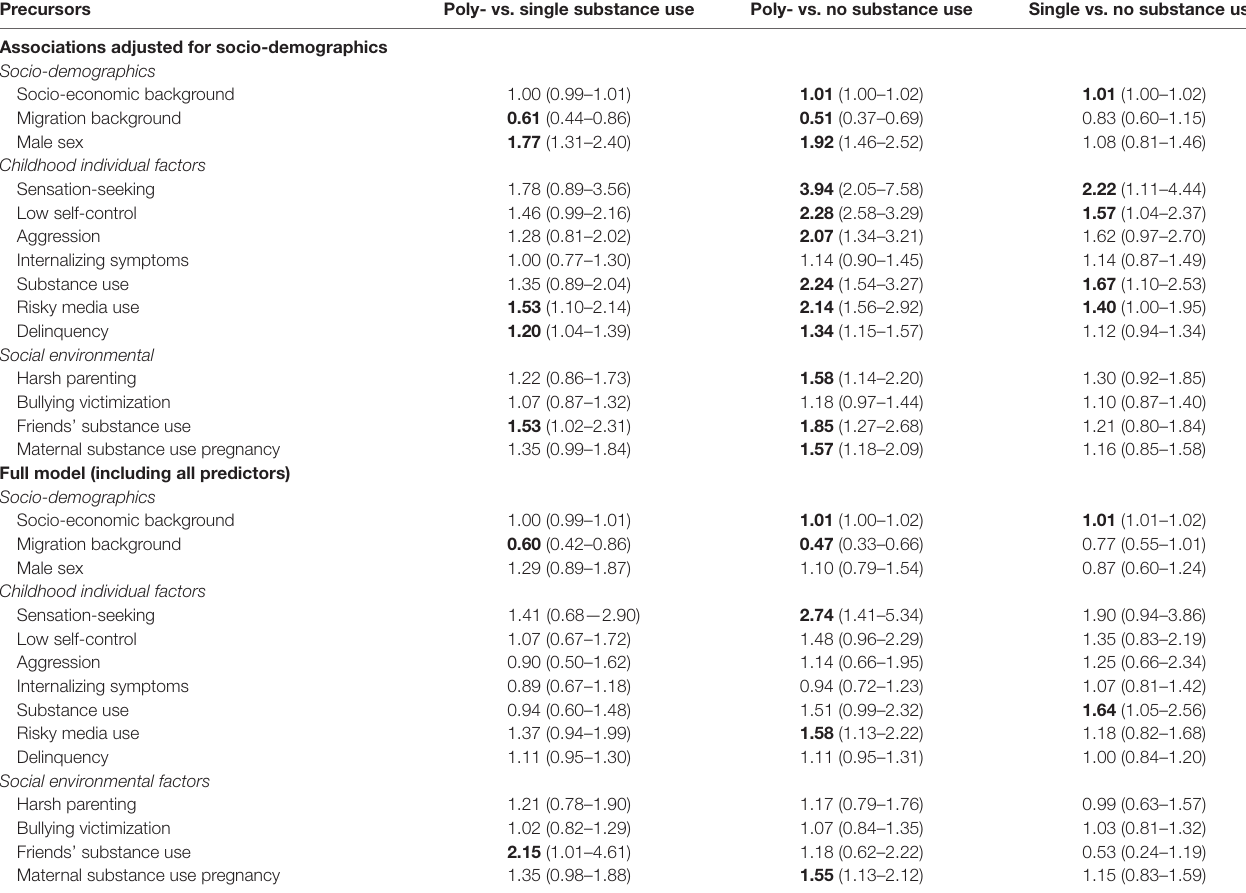
TABLE 2 | Associations between potential risk factors and early adulthood substance use status (nominal logistic regressions: OR, 95%